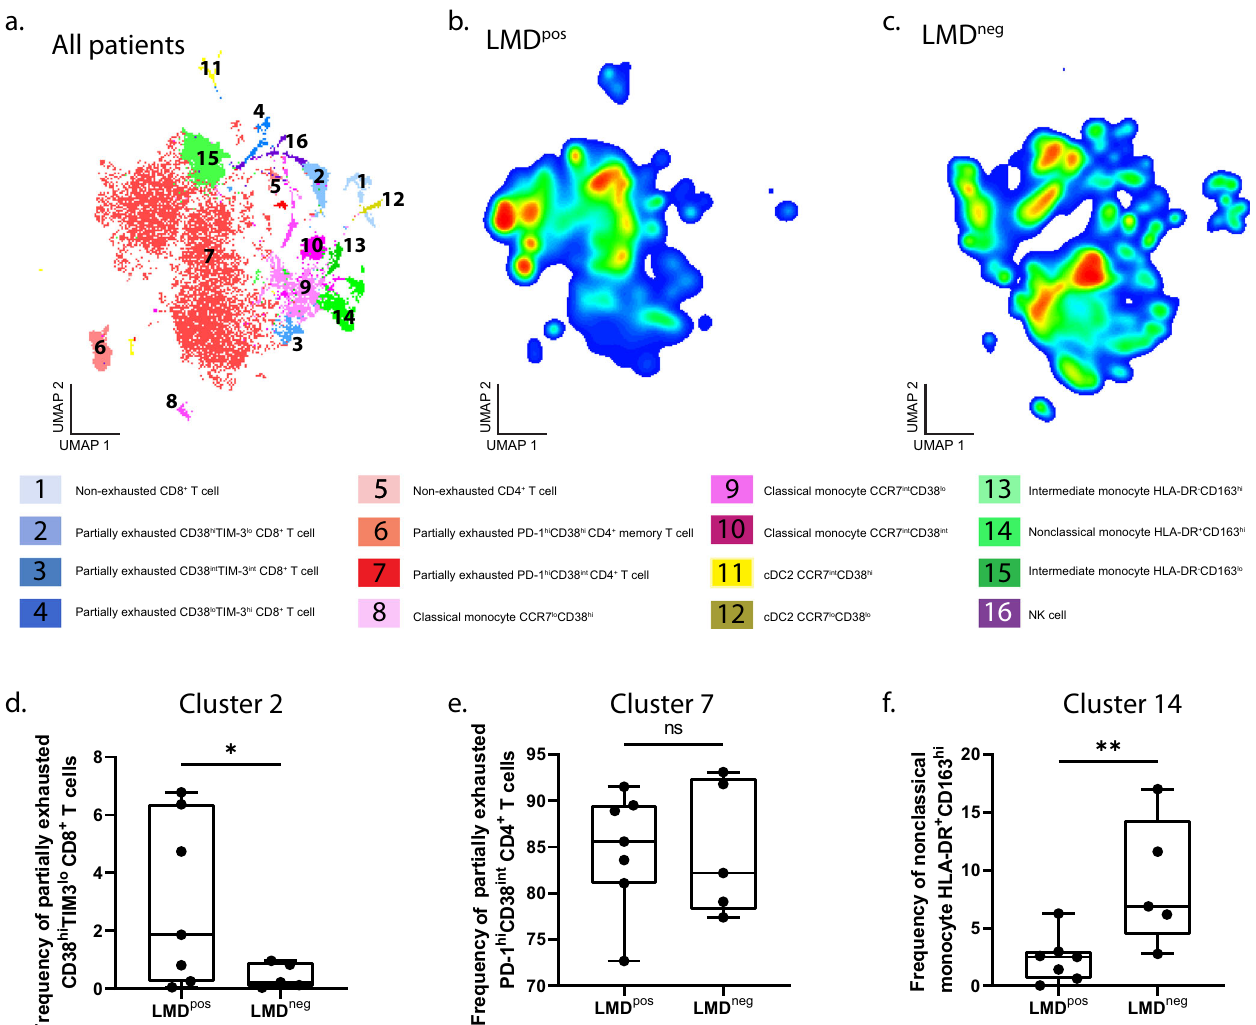
Fig. 3 High-dimensional immune cell pro fi ling in CSF reveals distinct CD8 + T and myeloid cell phenotypes. a UMAP projection of annotated clusters from all patients. b , c Density heat maps of immune cells in patients with LMD (LMD pos ) ( b ) and patients without LMD (LMD neg ) ( c ), with red representing the most prevalent cell types and blue representing the least prevalent cell types. d Frequency box plots of cluster 2, partially exhausted CD8 + T cell (CD38 hi TIM3 lo ), e cluster 7, partially exhausted CD4 + T cells (PD-1 hi CD38 int ), and f cluster 14 nonclassical monocytes expressing HLA-DR and CD163 hi . For box plots in this fi gure, the boxes indicate the interquartile range, while the lower and upper bars correspond to the minimum and maximum non-outlier values of the data distribution. Centerline indicates the median value. Statistical signi fi cance was assessed in d – f by one-way ANOVA followed by the Tukey post hoc test. (* or **) indicates statistical signi fi cance with p < 0.05, p < 0.01 respectively. n.s not signi fi